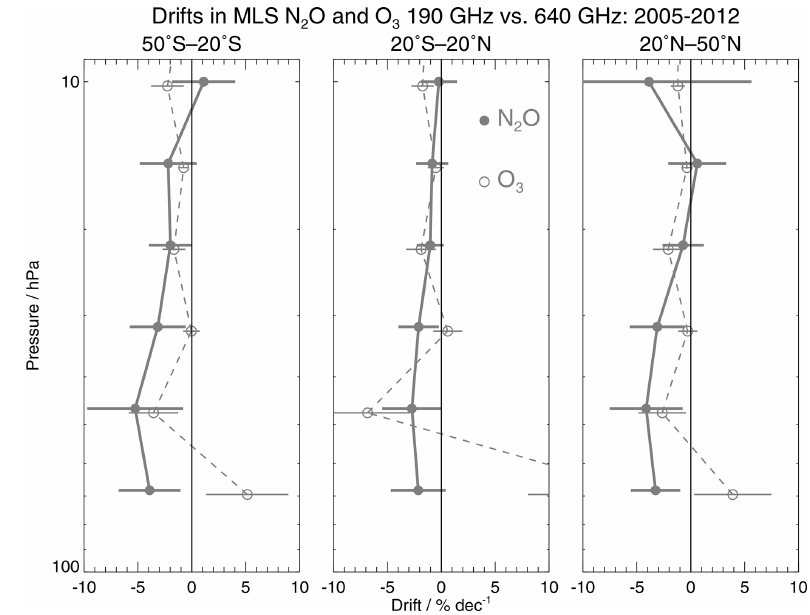
Figure 8. Drifts between MLS 190 and 640GHz N 2 O products from 2005 to 2012 over three latitude bins. Also shown (dashed line) is the corresponding drift seen between MLS 190 and 640GHz ozone. Error bars are 2 σ intervals estimated from block bootstrapping, as described in the text.